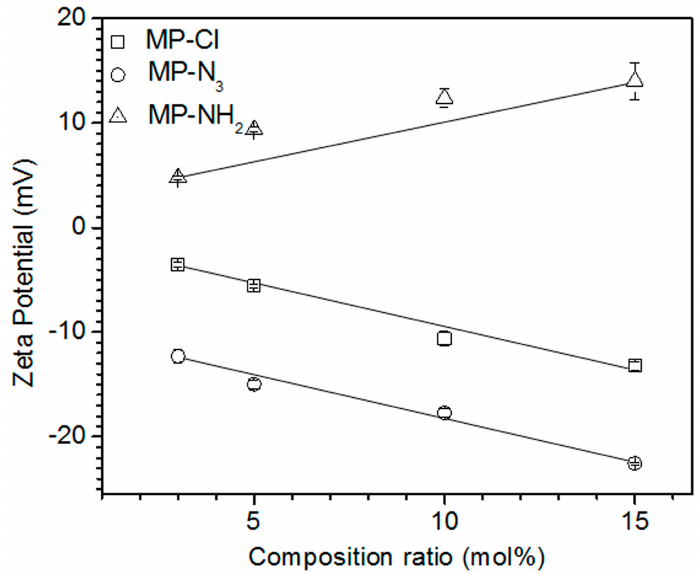
Figure 4. Zeta potential versus block composition ratios for MP-Cl, MP-N 3 and MP-NH 2 diblock copolymers with 3–15 mol % of chloride, azide and amine pendant groups.